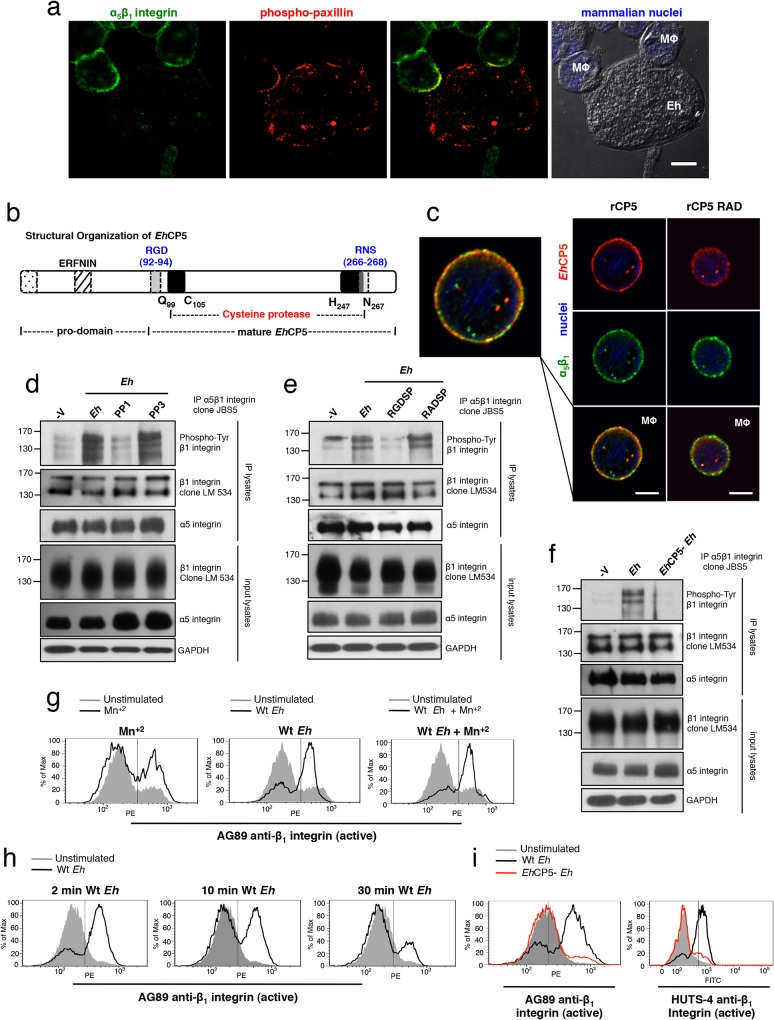
α5β1 integrin is activated by Eh contact via a surface-bound-integrin-binding Eh cysteine protease.(a) Localization of α5β1 integrin (green) and phosphorylated (active)-paxillin (red) in PMA-differentiated macrophages at sites of Eh contact; mammalian nuclei, blue (Eh nuclei are not labeled). (b) Diagram showing structural organization of EhCP5. (c) Subcellular distribution of EhCP5 (red) and α5β1 integrin (green) after THP-1 macrophages were cultured with rCP5 (left) or rCP5 in which the RGD site was mutated to RAD (right); nuclei, blue. (d-f) Immunoblot analysis of β1 integrin tyrosine phosphorylation (clone PY20) of anti-α5β1 integrin immunoprecipitates from PMA-differentiated THP-1 macrophages stimulated with Wt Eh (d-f), with PP1 or PP3 control (d), or blocking peptide RGDSP or RADSP control (e) added to cultures 10 min before stimulation, or EhCP5- Eh (f). (g-i) Activation status of β1 integrin in PMA-differentiated THP-1 macrophages stimulated with Wt (g-i), or EhCP5- Eh (i) evaluated with anti-β1 integrin mAbs, AG89 (g-i) and HUTS-4 (i) that recognize the active conformation specific epitope of β1 integrin. Scale bars, 10 μM. Data are representative of two (a, c, i) or three (d-h) separate experiments.